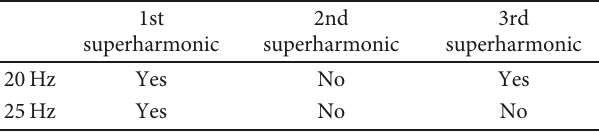
Figure 28: D2, direct response FFT, 20Hz sine excitation. FFT acceleration story on node 93, sine force with f = 25 Hz